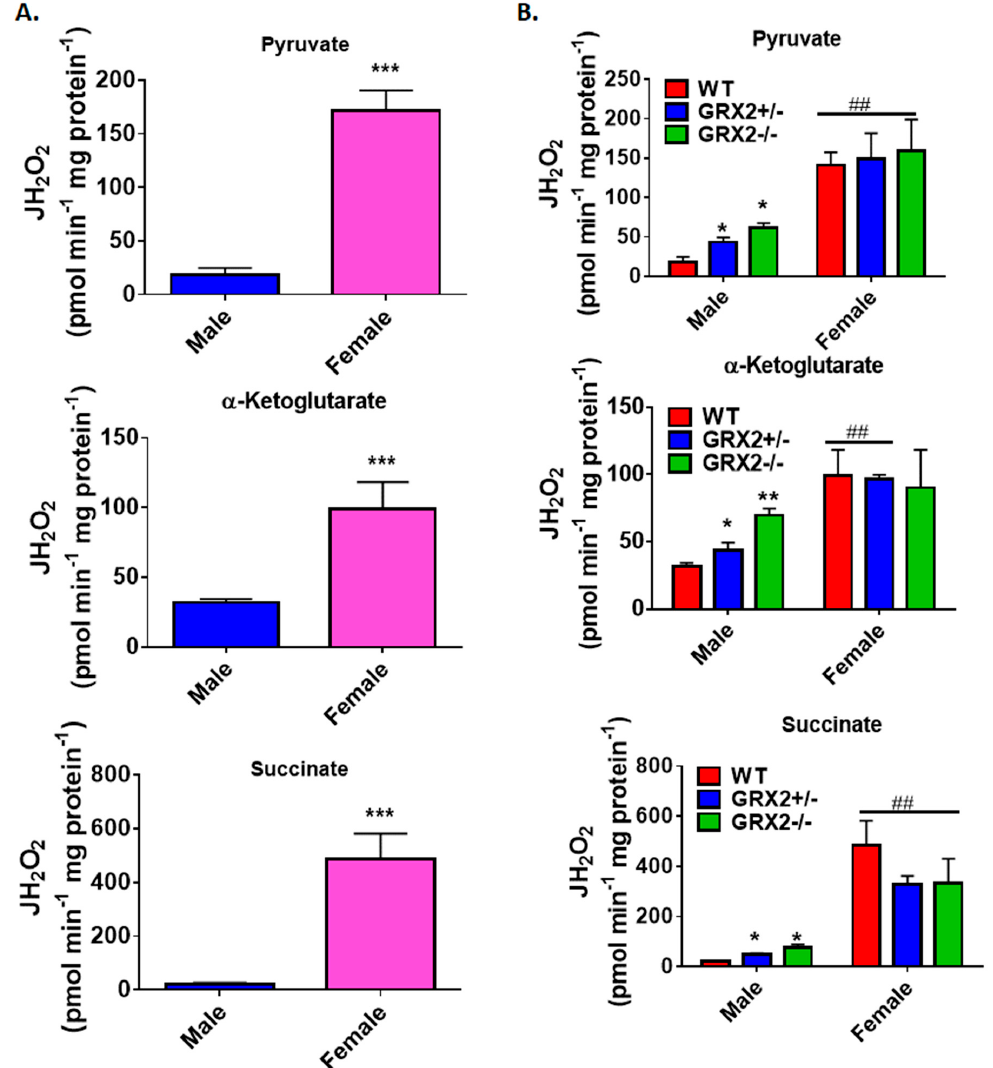
Figure 5. Examination of the sex differences associated with H 2 O 2 production by muscle mitochondria isolated from female and male littermates deficient for GRX2. ( A ). Comparison of the rate of H 2 O 2 production by muscle mitochondria isolated from male and female WT littermates and energized with 50 µ M pyruvate, α -ketoglutarate, or succinate. n = 4, mean ± SEM, two-tailed Student’s T -Test. ( B ) Impact of GRX2 deficiency on rates of ROS production by muscle mitochondria from male and female mice. n = 4, mean ± SEM, 2-way ANOVA with a post-hoc Tukey’s test. *: p ≤ 0.05, ** or ##: p ≤ 0.01, ***: p ≤ 0.001